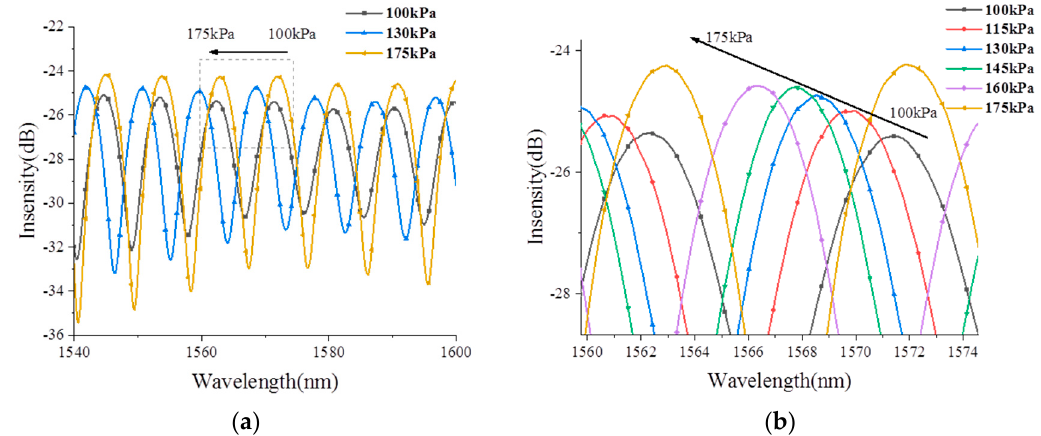
Figure 8. Spectrum characteristics of sensor S1. ( a ) Spectrum range from 1540 to 1600 nm ; and ( b ) spectrum range from 1560 to 1575 nm .